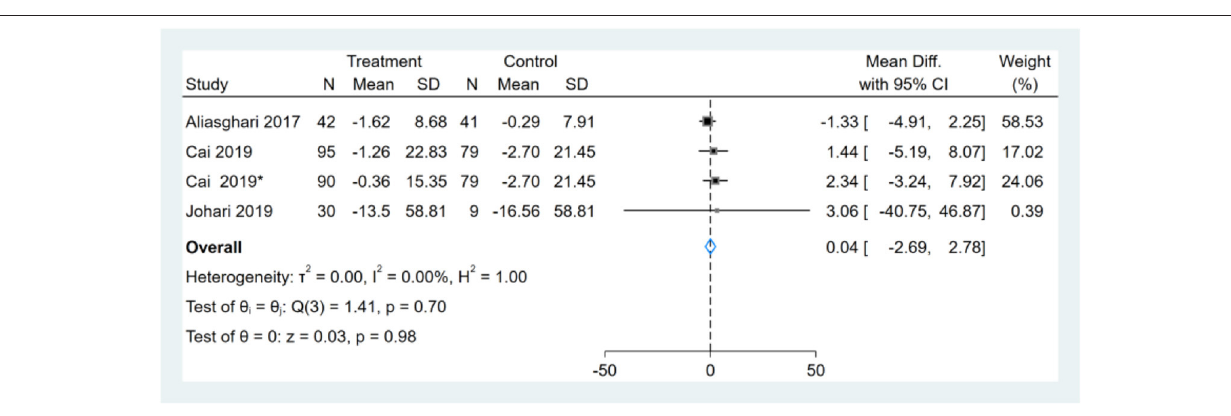
significant (MD, 0.50, 95% CI from 0.93 to 0.07, p − − − = 0.02) ( Figure 3 ). Negative values favor fasting because the fasting group experienced more reduction in BMI than did the comparators, and two datasets were included (13). Therefore, control group. a total of three WC datasets were included in the